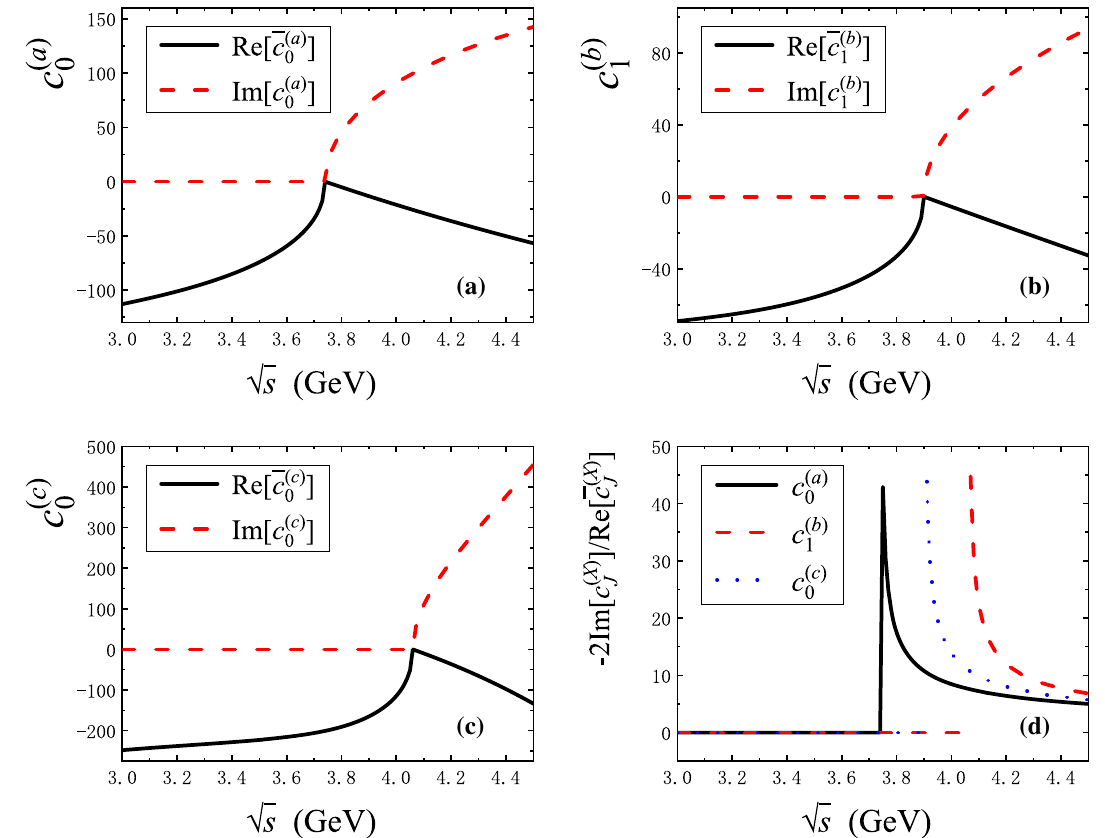
√ √ ] vs. ] vs. s , Re [ c ( a , b , c ) s and − 2Im [ c ( a , b , c ) J J √ ] vs. s , respectively. The sub figure ( d ) shows the results for − 2Im [ c ( X ) J